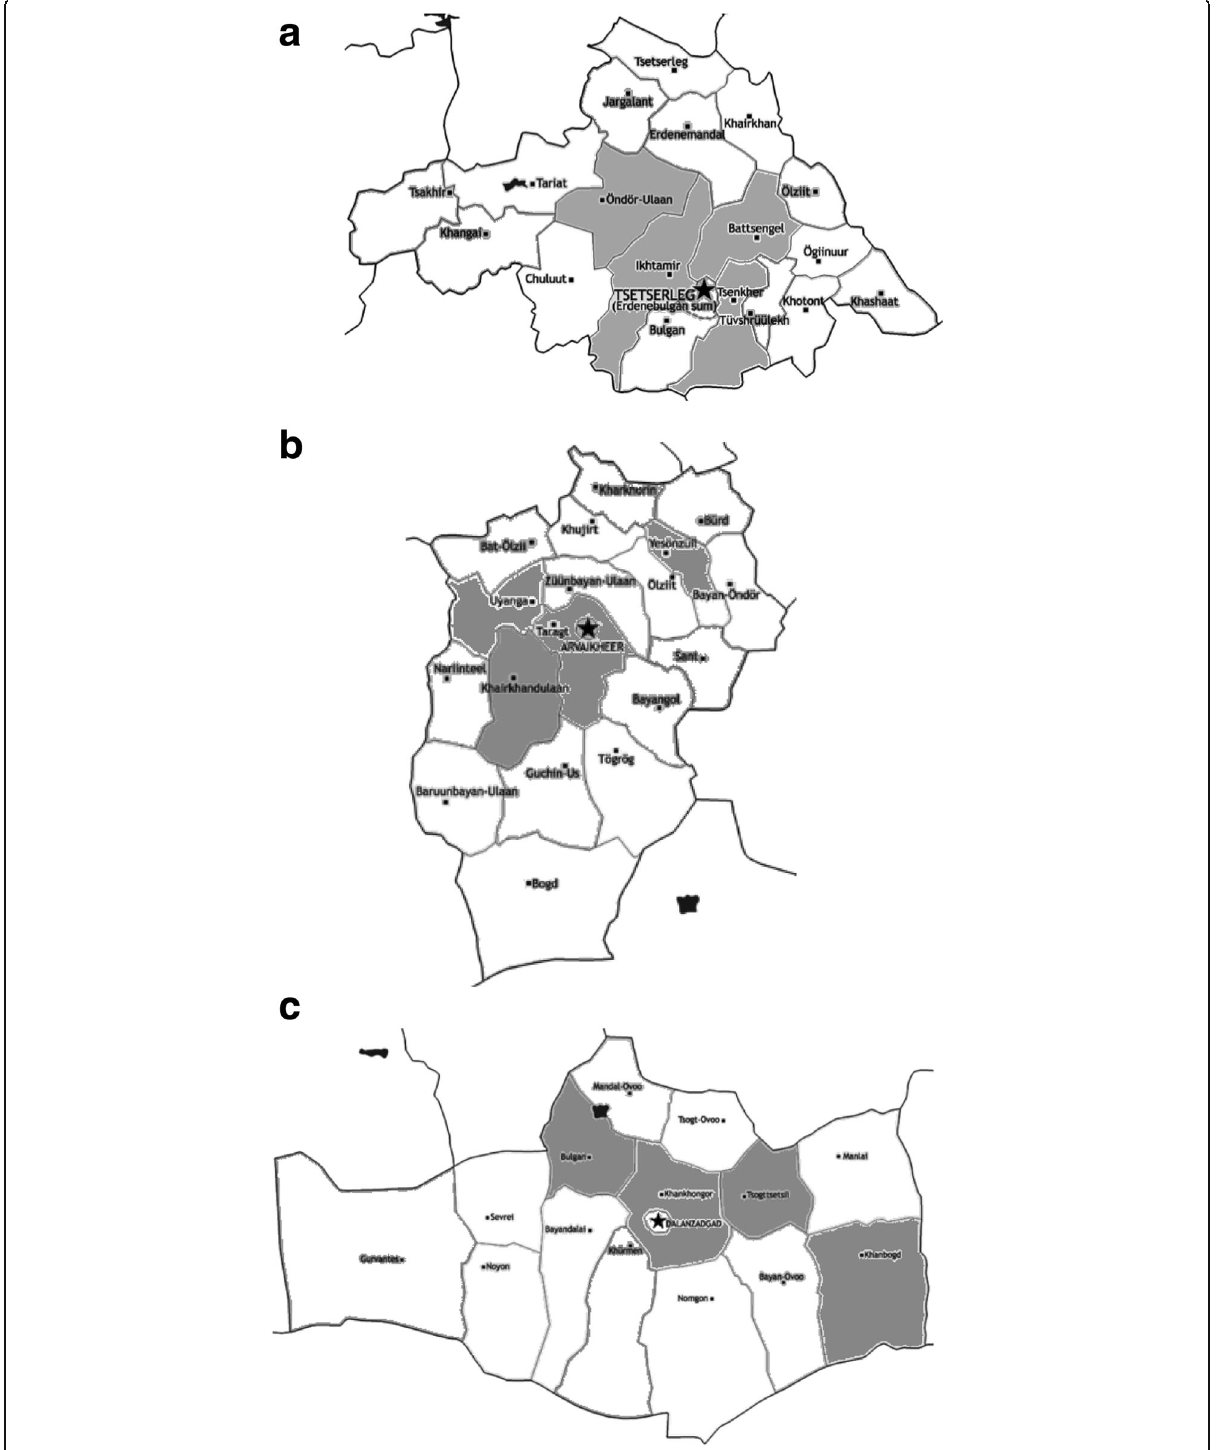
Figure 3 Location of study sites in each aimag. Four soums were surveyed in each aimag: Arkhangai ( a ), Uvurkhangai ( b ), and Umnugobi ( c